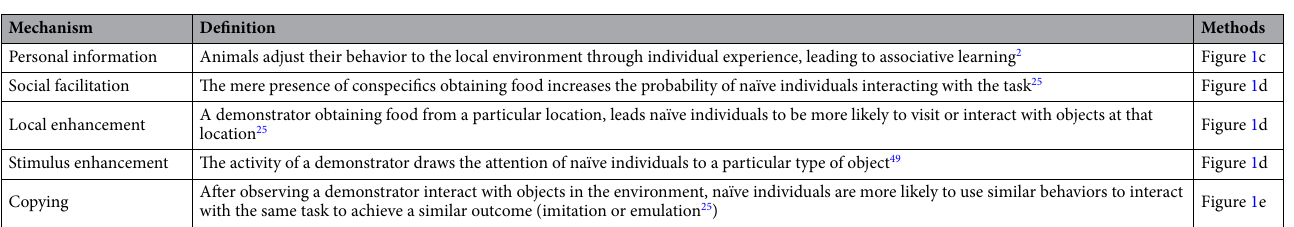
Table 1. Definitions for the learning mechanisms examined in this study, and the locations in Fig. 1 where the methods for measuring each mechanism are